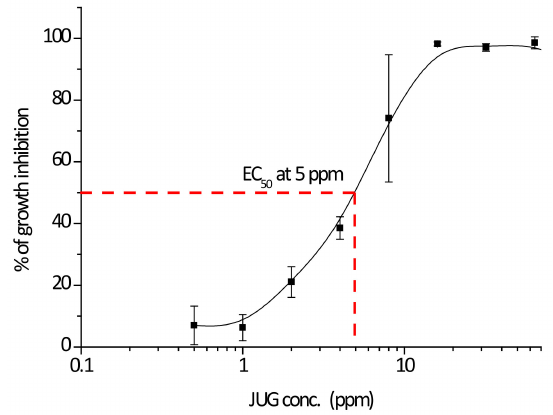
Figure 1. Inhibition of growth for C. marina (Absorbance, OD 595 ) in the presence of juglone at concentrations 64, 32, 16, 8, 4, 2, 1, and 0.5 ppm ( x -axis). Error bars ±